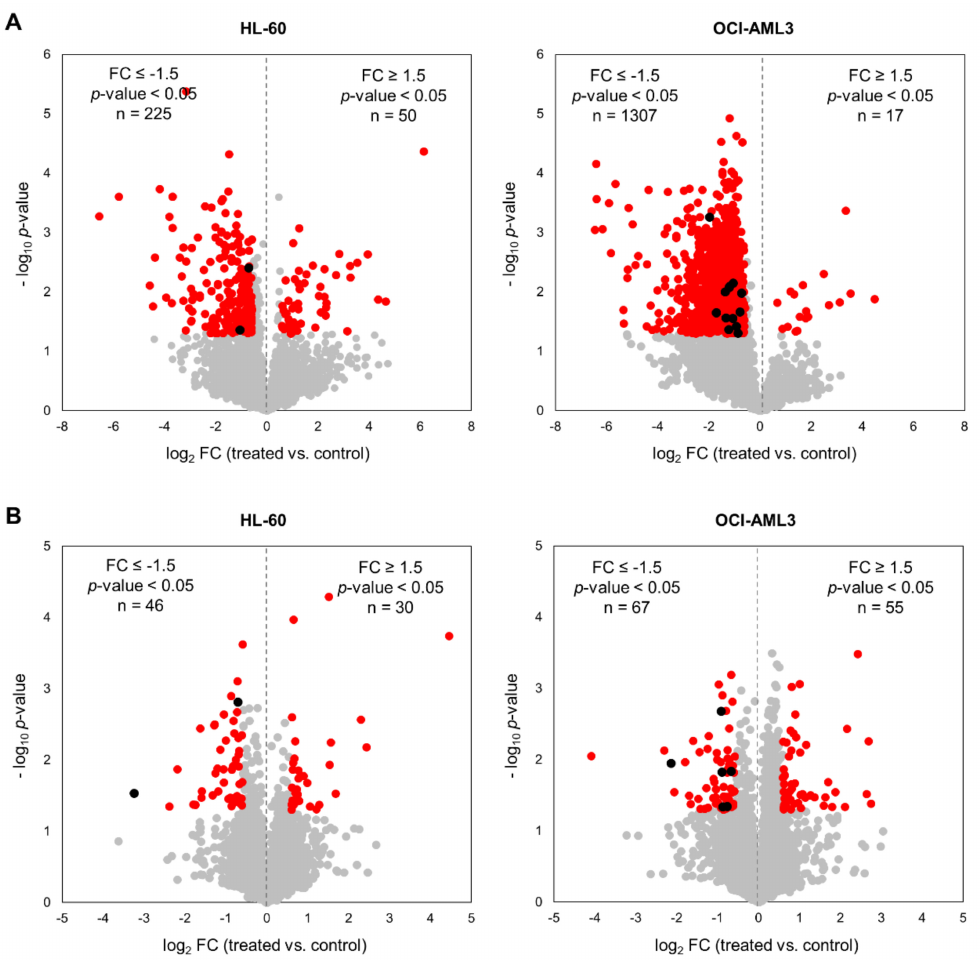
Figure 2. Phosphoproteomic and proteomic profile of human AML cells treated with the CK2 inhibitor CX-4945. Volcano plots of quantified ( A ) phosphopeptides and ( B ) proteins from HL-60 and OCI-AML3 cells after treatment with 5 µ M CX-4945 during 8 h. Red points indicate those phosphopeptides/proteins that met statistical significance cut-off (|FC| ≥ 1.5, p -value < 0.05). Additionally, black points indicate those phosphopeptides with decreased phosphorylation due to the reduction of the corresponding protein abundance in proteomic analysis (down-regulated proteins are also indicated in